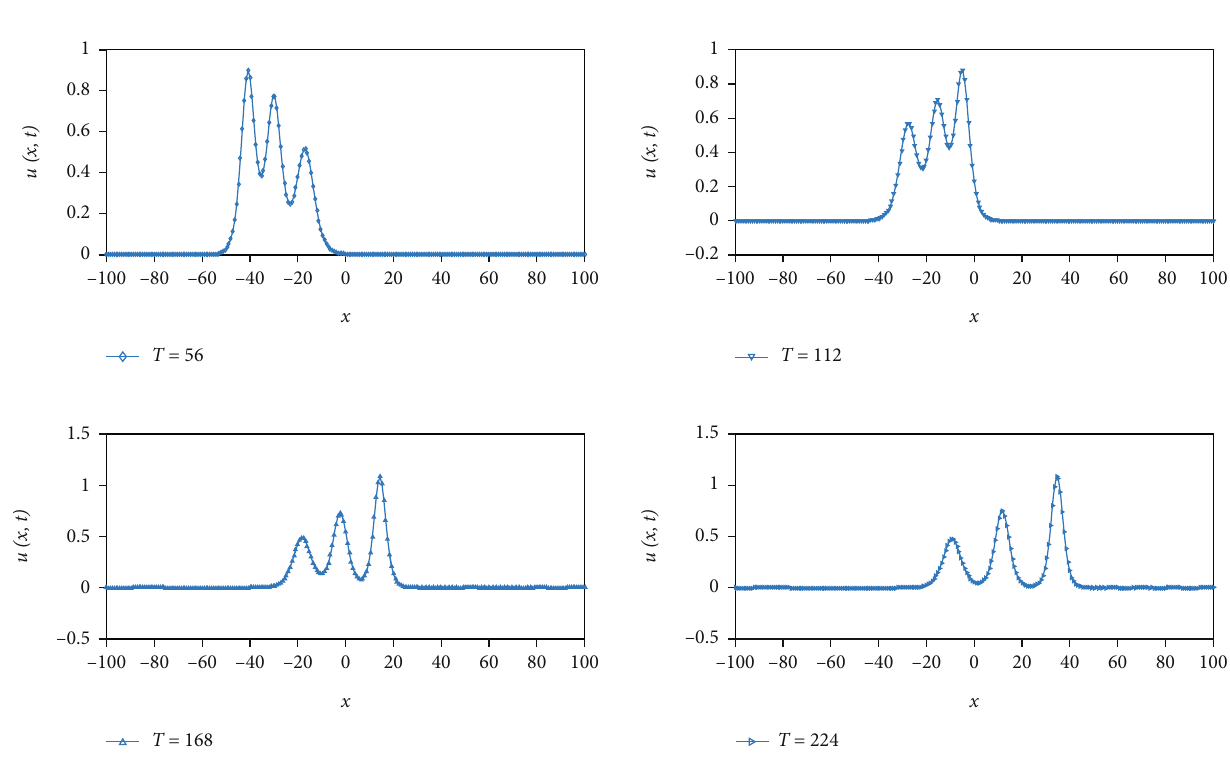
Figure 4: Simulations of three solitons: Δ t = 0 : 1